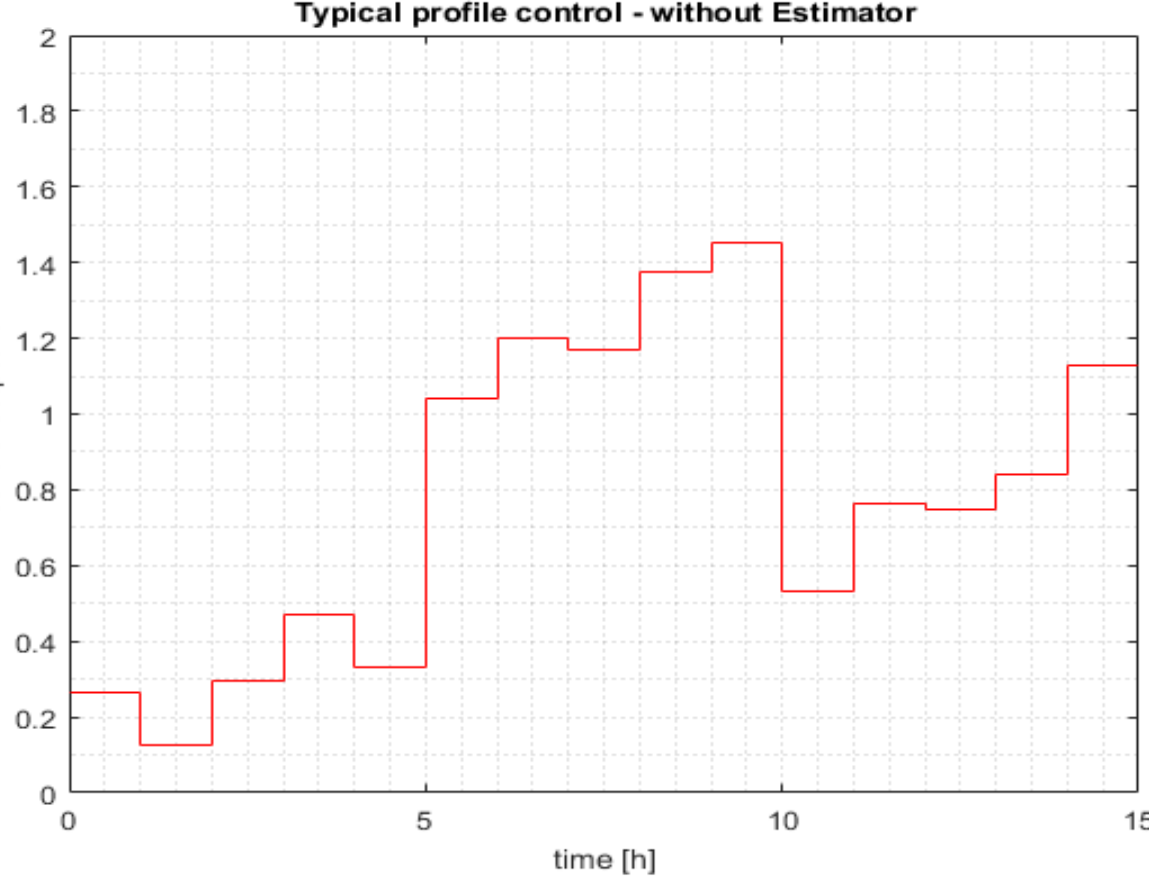
Figure 4. Typical control output—controller without control input range estimation.